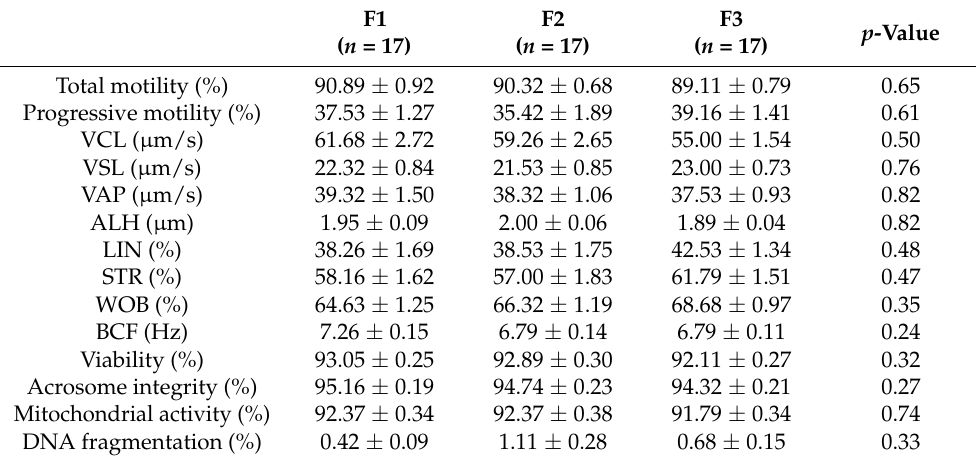
Table 2. Spermatozoa quality parameters from different accumulative ejaculate fractions (F1, F2, F3) analyzed after 3 days of storage at ~16 ◦ C. Data are expressed as the mean ± SEM (standard error of the